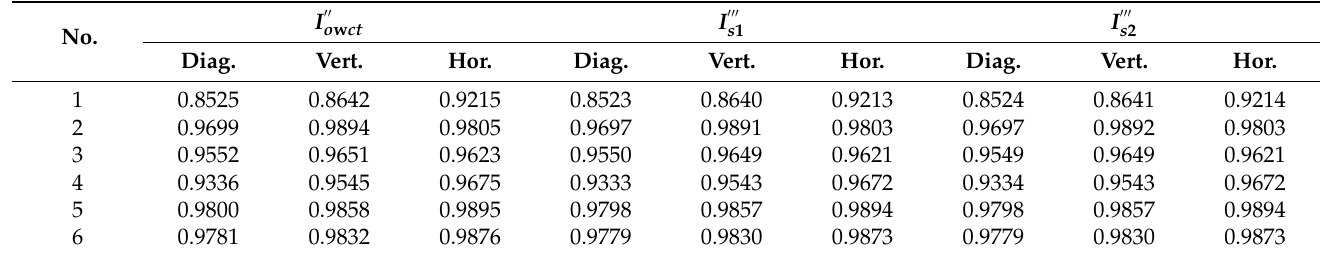
Table 12. The correlation coefficients of six test images in three directions in Red channel.